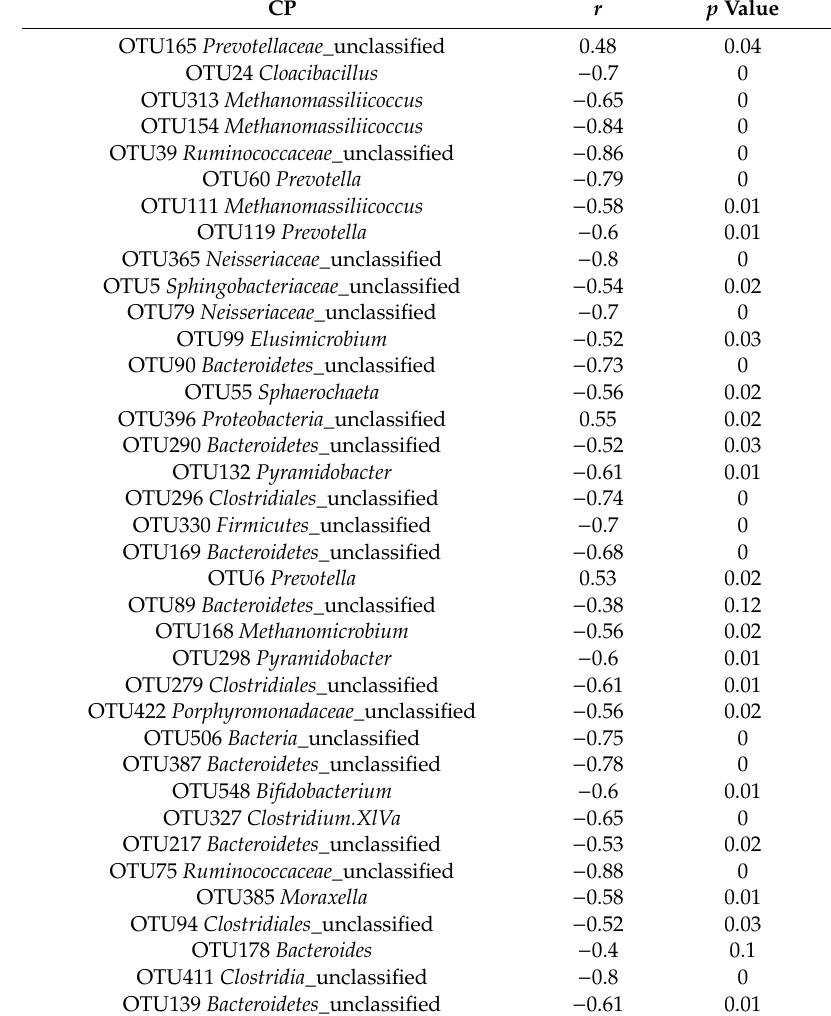
Table 1. Correlation analysis between nutrient (CP, NFC and NDF) intake and rumen microbes in goat kids. We performed the Random Forest regression model across all samples between dietary average daily CP, NFC and NDF intake and all the bacteria with high prediction accuracy (Table S6). Then, using the abundances of top 50 features to calculate the Pearson correlation with intake of CP, NFC and NDF was carried out. We consider p < 0.05 as a significant correlation. The bacteria from up to bottom followed the descending order of mean square error. CP: Crude protein average daily intake;